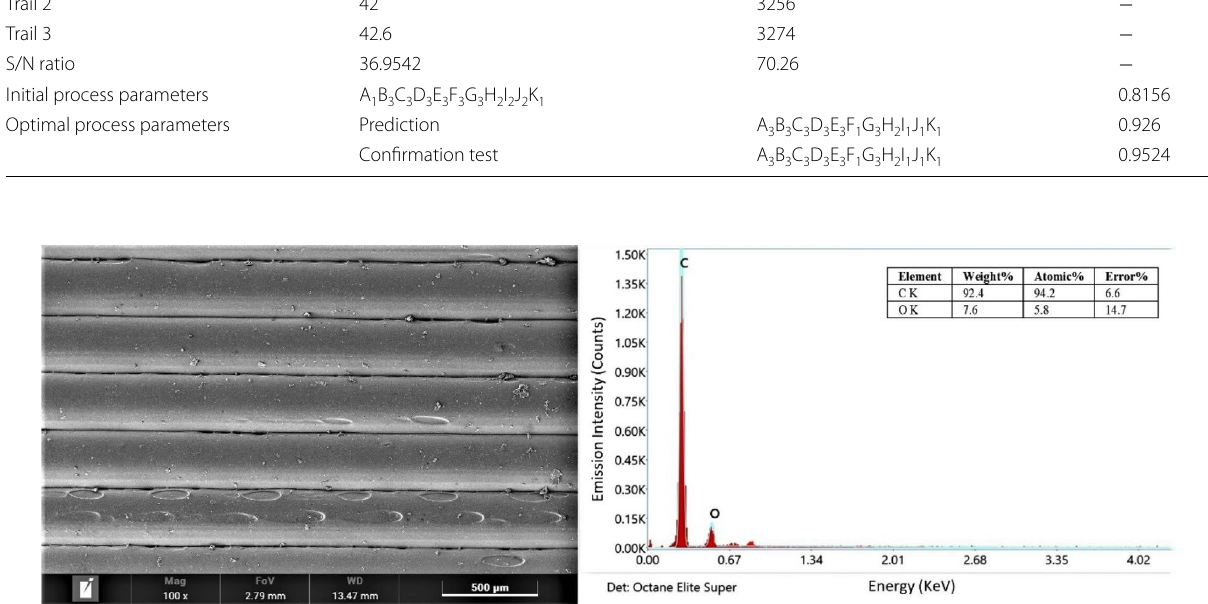
Figure 8 SEM micrograph of specimen obtained from confirmation experiment and EDX spectra of